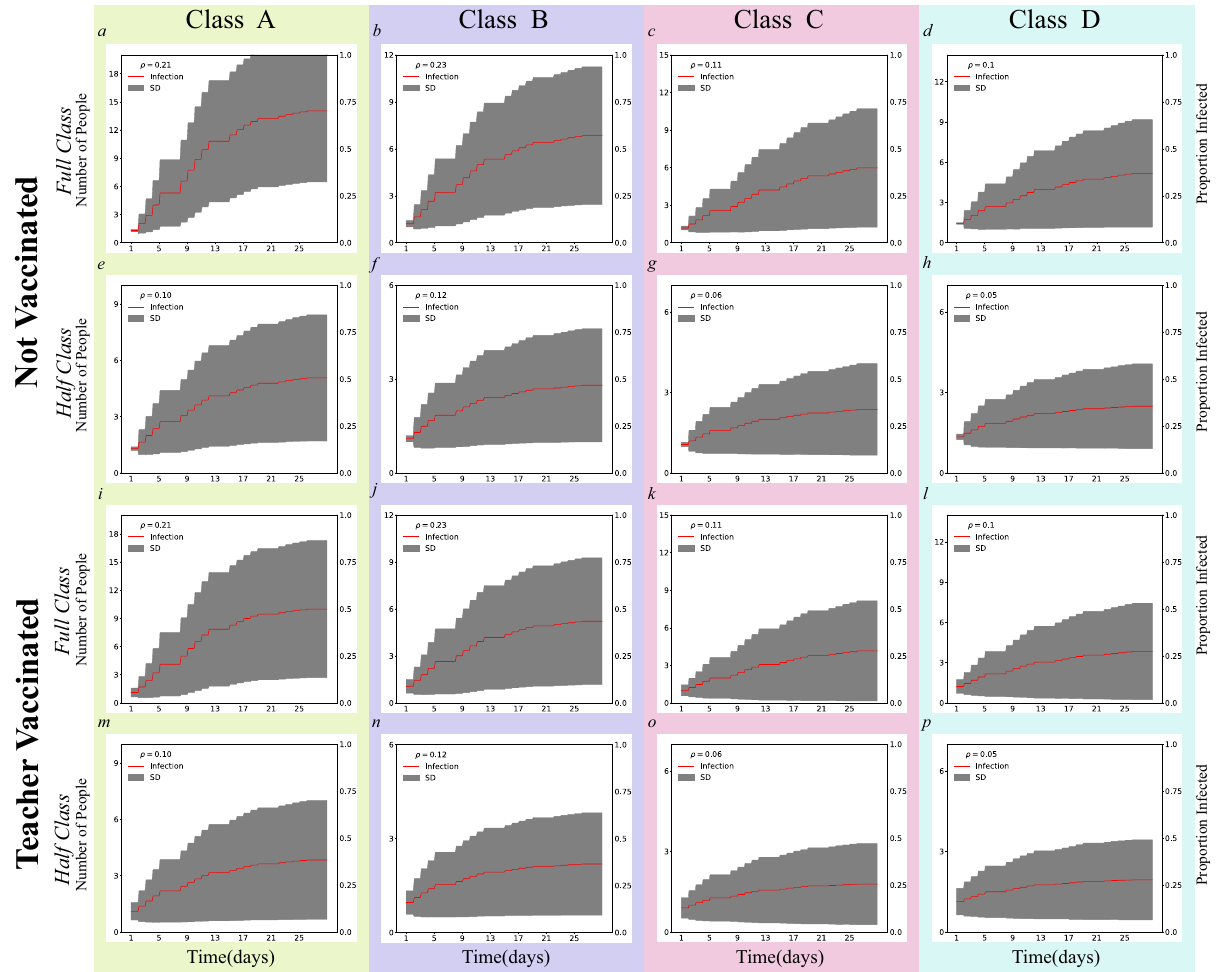
Figure 3. SARS-CoV-2 Infection over Time. The proportion (right) and total number (left) of infections over time in days . Trajectories are simulated for four classes for the full versus half-sized scenarios and not vaccinated versus teacher-vaccinated scenarios. The red curves and grey areas represent the mean and standard deviation of the proportion/total number of infections for all observations, respectively. ρ ’s in each legend represent the classroom densities in the unit of people per m 2